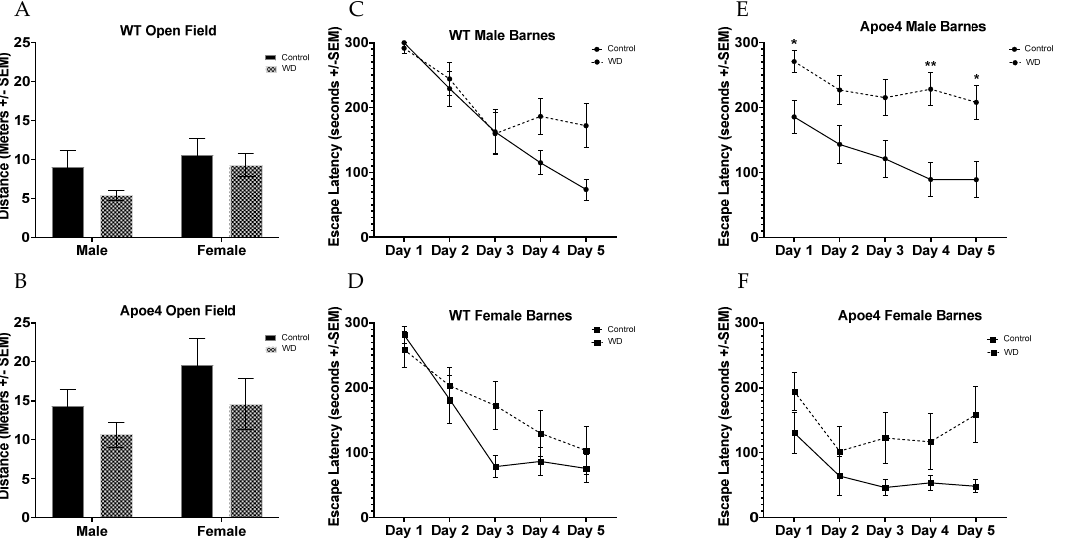
Figure 7. Behavioral assays. Both male and female WT ( A ) and ApoE4 ( B ) mice fed WD trended toward less activity in the open-field test. WT male and female mice fed WD ( C , D ) showed marginally slower latency to escape in the Barnes maze. In contrast, both male and female ApoE4 mice fed the WD ( E , F ) showed consistently longer latencies to escape, with this effect being significant and most pronounced in the male mice ( E ). It should be noted that control diet ApoE4 mice ( E,F ) showed consistently shorter latencies to escape than WT ( C,D ) control-diet-fed animals and non-significant differences in ambulation in the open-field where ApoE4 animals ( B ) ambulated more than WT animals ( A ), regardless of sex. * p < 0.05, ** p <